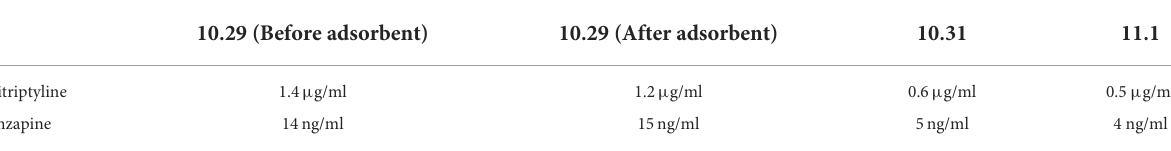
TABLE 1 Concentrations of amitriptyline in the patient’s